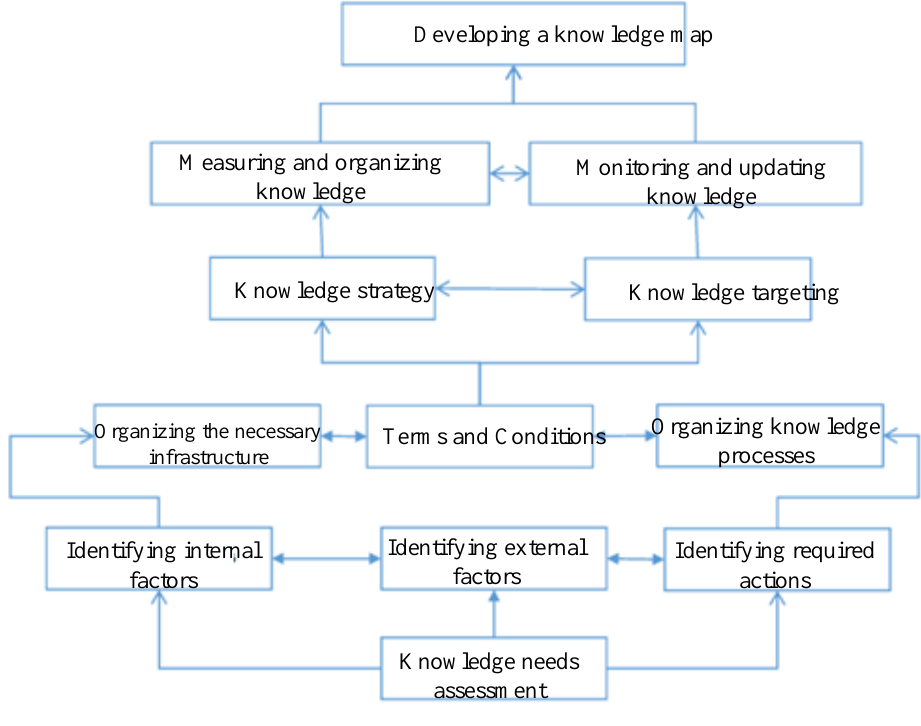
Figure 3: Comprehensive proposed model for intelligent /smart organizational knowledge